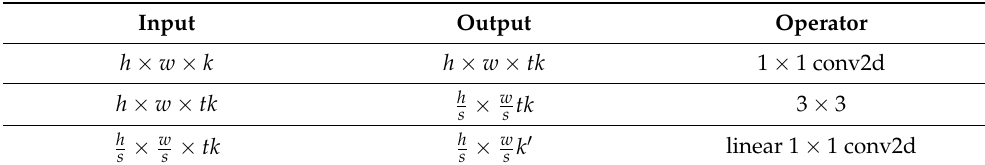
Table 3. Inverted residuals block transforming from k to k (cid:48) .